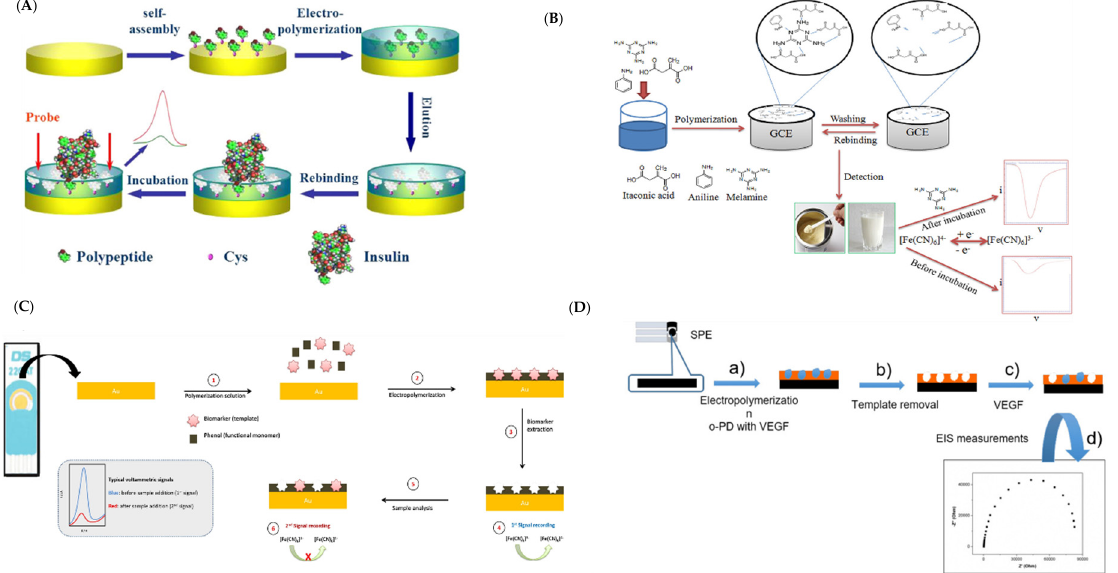
Figure 9. Electrochemical methods as a tool for preparation of MIP ‐ layers and detection of target